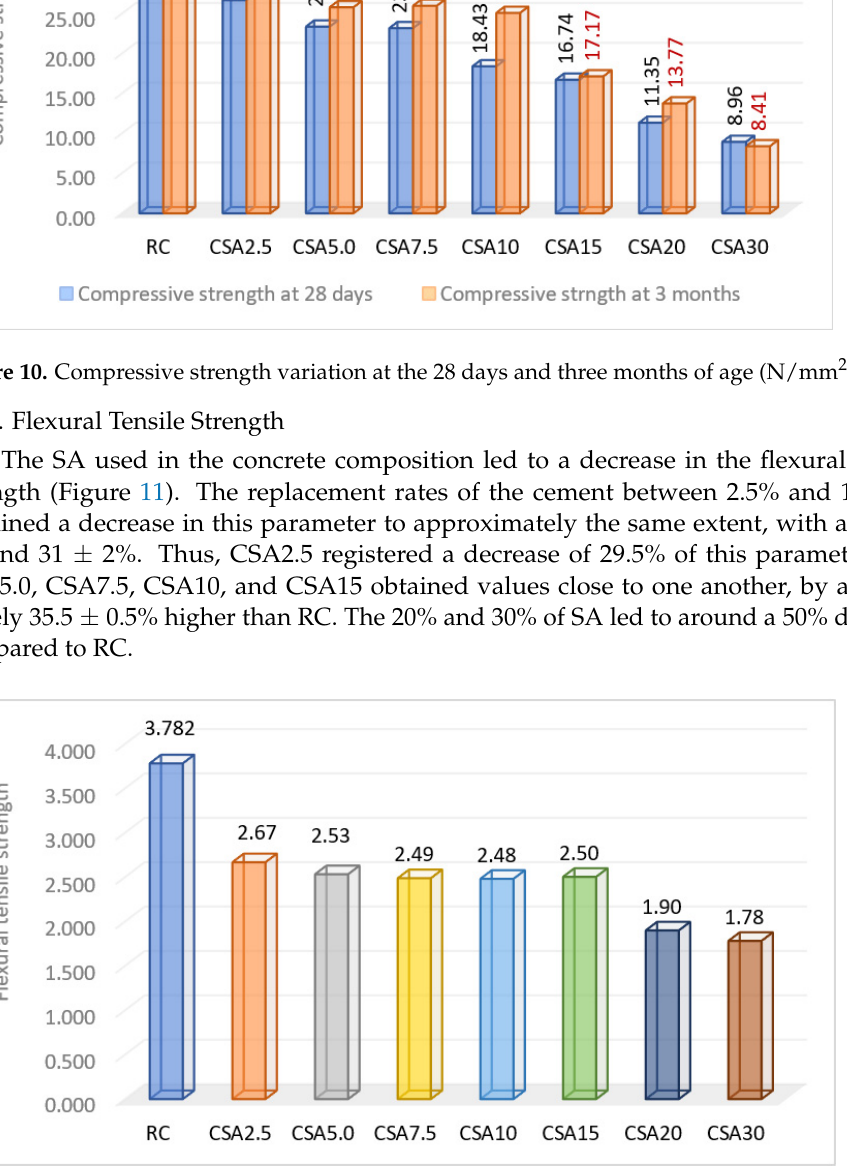
Figure 11. Flexural tensile strength of the composite samples (N/mm 2 ).